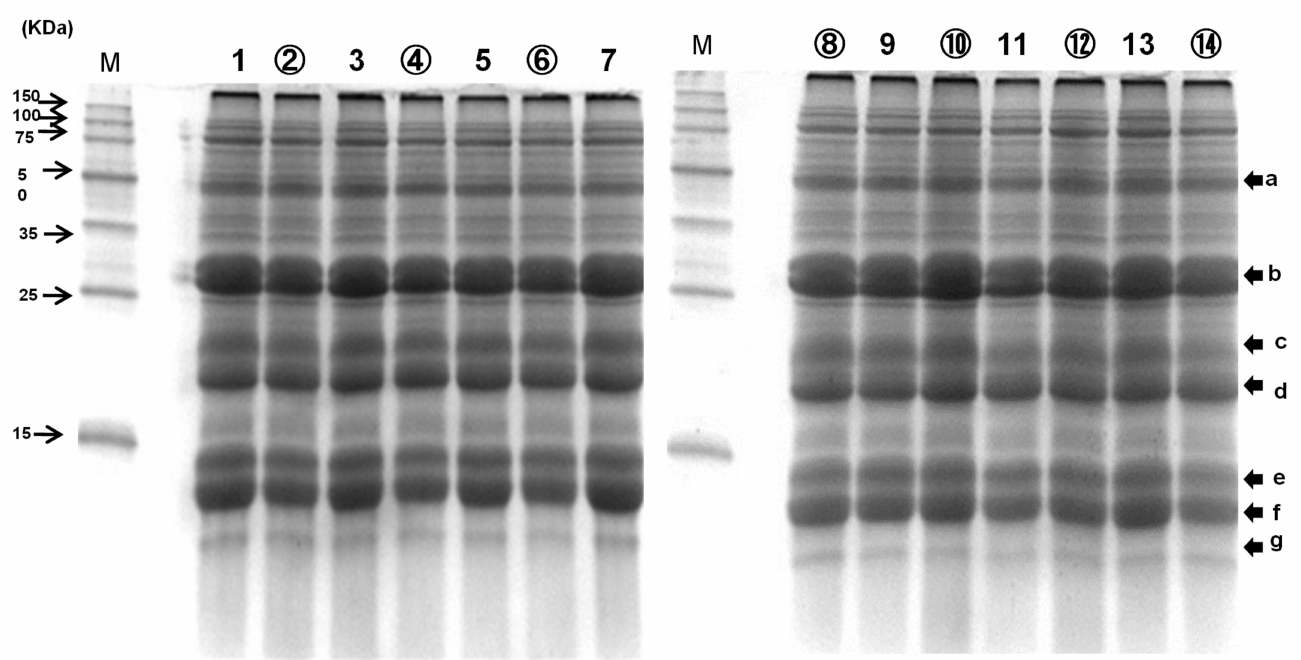
Figure 3. SDS-PAGE analysis of proteins extracted from whole and chalky rice grains of Japonica rice samples in a high temperature environment; 1, Koshihikari (Toukamachi) whole grain; 2, Koshihikari (Toukamachi) Chalky grain; 3, Koshihikari (Shibata) Whole grain; 4, Koshihikari (Shibata) Chalky grain; 5, Koshihikari (Tochio) Whole grain; 6, Koshihikari (Tochio) Chalky grain; 7, Morinokumasan (Whole grain); 8, Morinokumasan (Chalky grain); 9, Hanaechiden (Whole grain); 10, Hanaechzen (Chalky grain); 11, Koshihikari (Oguni) Whole grain; 12, Koshihikari (Oguni) Chalky grain; 13, Sasanishiki (Whole grain); 14, Sasanishiki (Chalky grain). SDS-PAGE; Sodium dodecyl sulfate polyacrylamide gel electrophoresis; Chalky rice grains is in circled numbers; a; Gluterin precursor, b; Glutelin α -subunit, c; α -Globulin, d; Glutelin β -subunit, e; f; g;